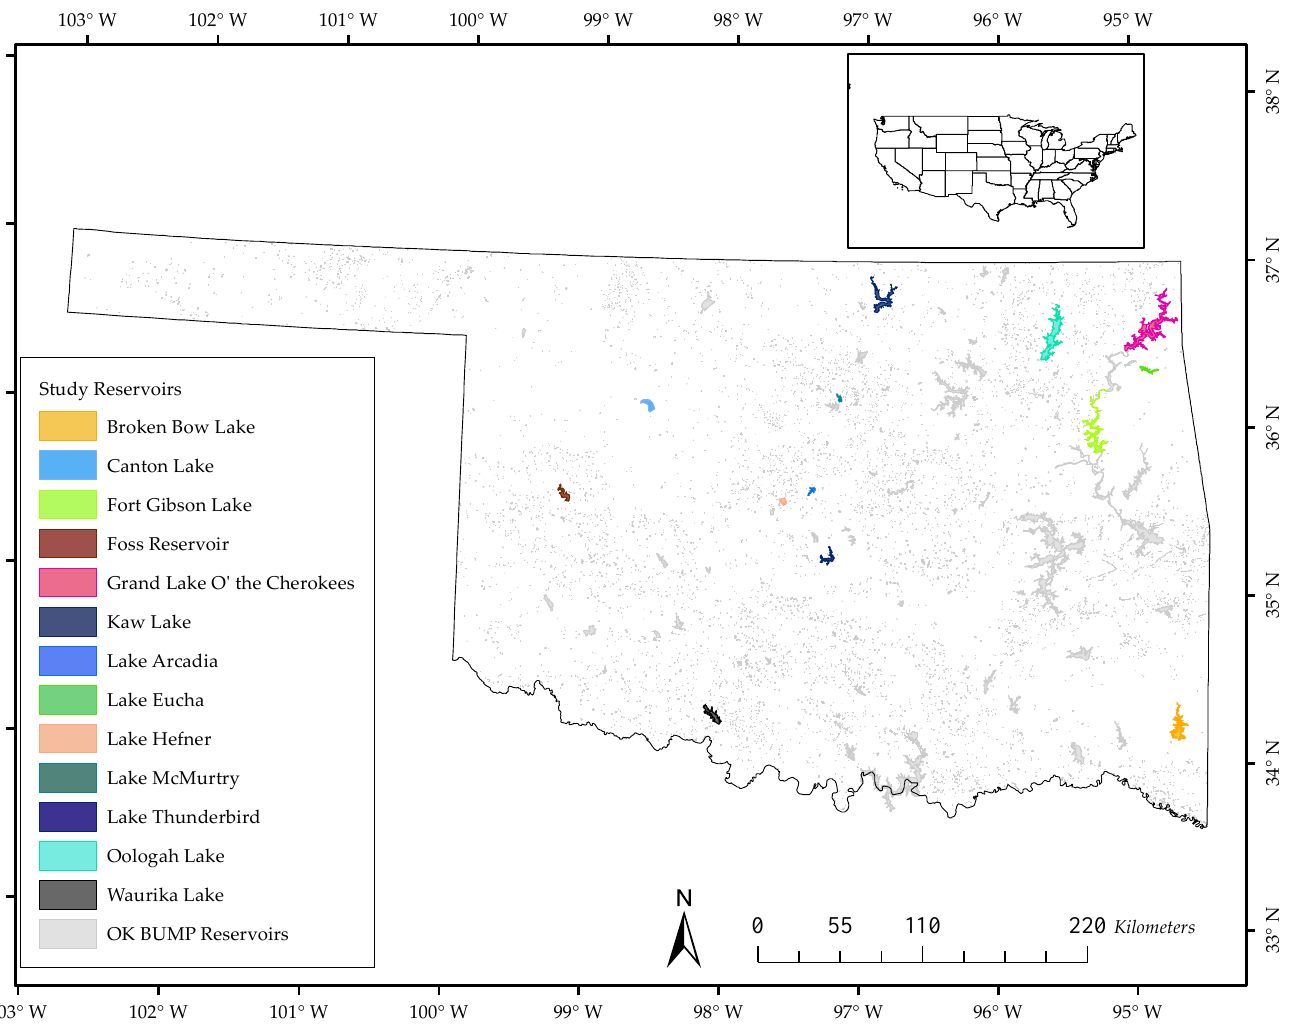
Figure 1. Map of Oklahoma showing the BUMP reservoirs across the state (grey polygons and speckles) and the 13 reservoirs used in this study (in colors). The spatial data for this map were obtained from the Oklahoma Water Resource Board’s website [34]. Table 2. Characteristics of the reservoirs used in this study. This information was obtained from the Oklahoma Water Resource Board’s website [37].